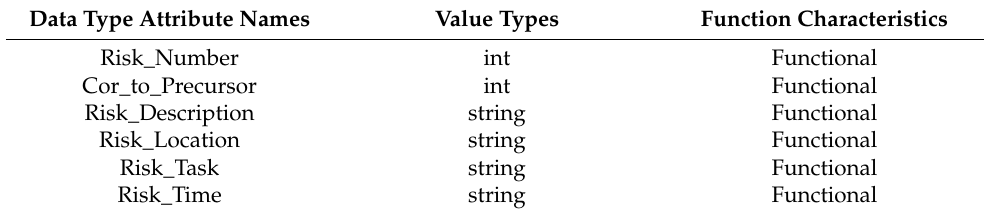
Table 6. Construction risk data type attribute